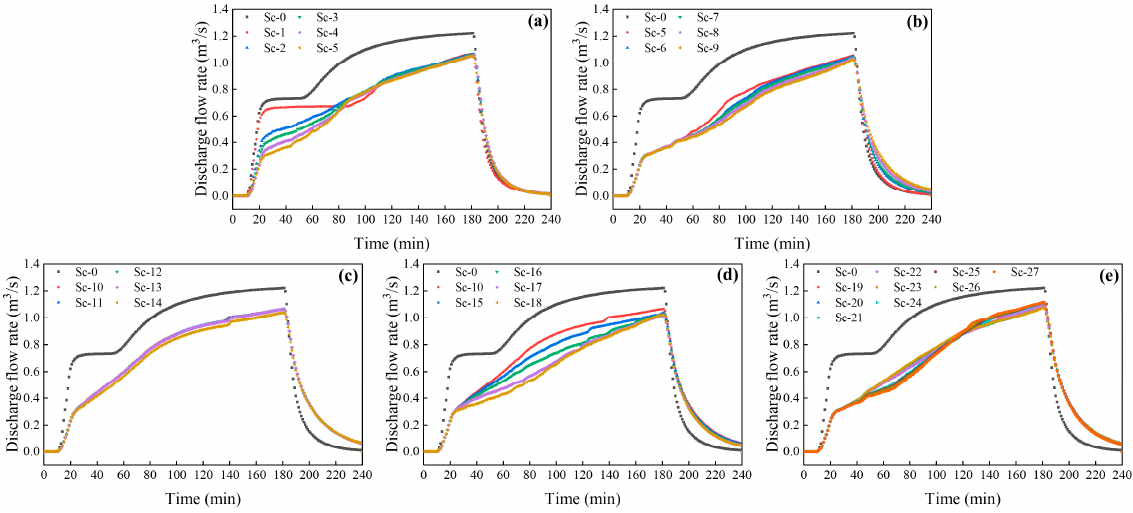
Figure 16. The time series plot of DFR in 3 h event in considered scenarios of ( a ) connectedness of GR; ( b ) connectedness of RG; ( c ) edge density of GR; ( d ) edge density of RG; ( e ) flow distance of RG.